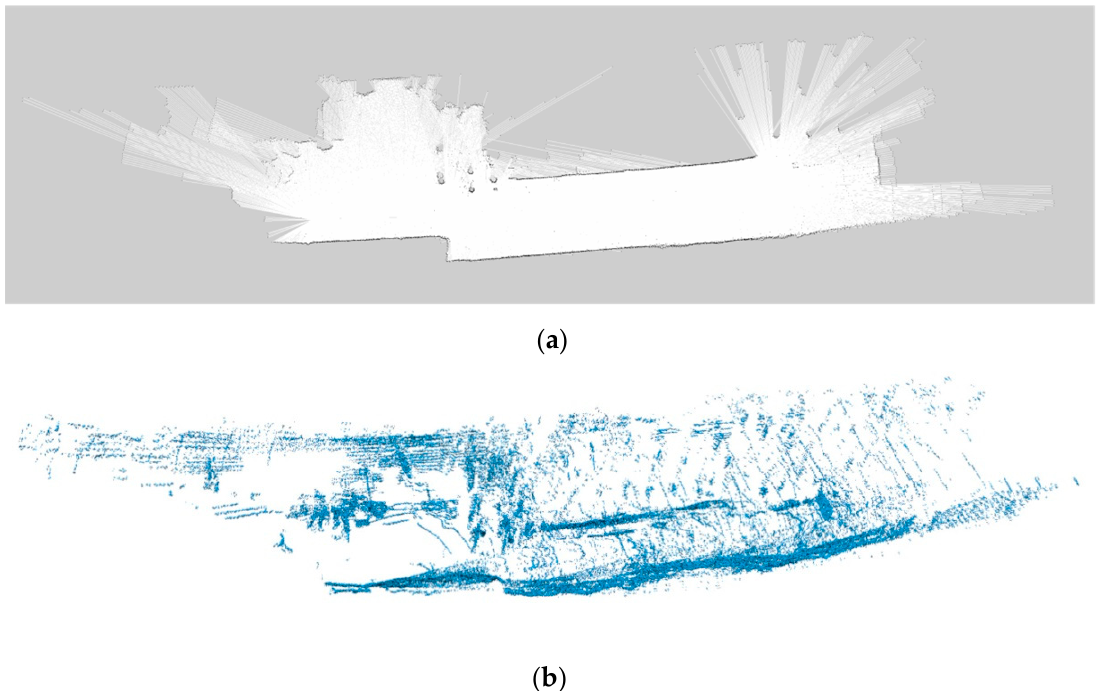
Figure 7. Maps obtained during underground inspection in the mine terrain after accident: ( a ) created with the use of 2D SLAM technique; ( b ) created with the use of proposed hybrid 3D SLAM approach.